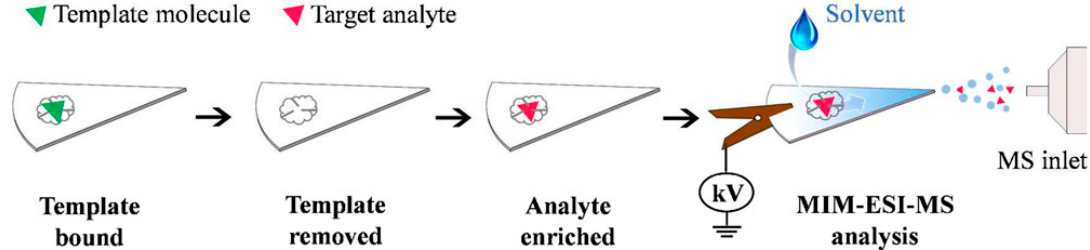
Figure 7. Workflow and analyte ionization in MIM-ESI. Reproduced with permission from [35].